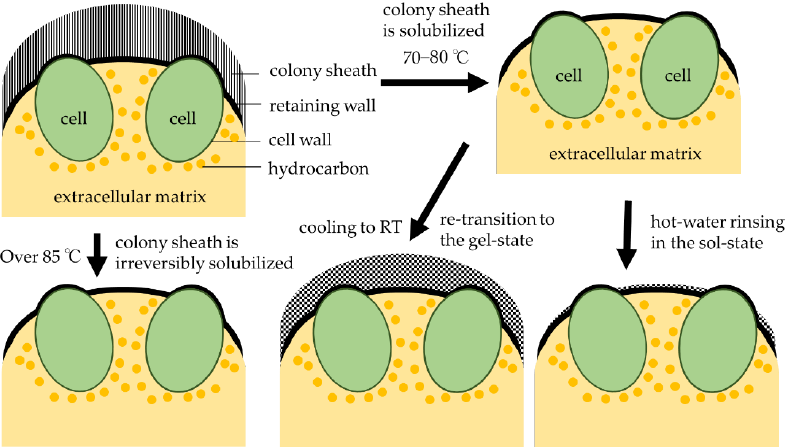
Figure 5. Schematic illustration of the effect of heating temperature and hot-water rinsing on colony sheath.